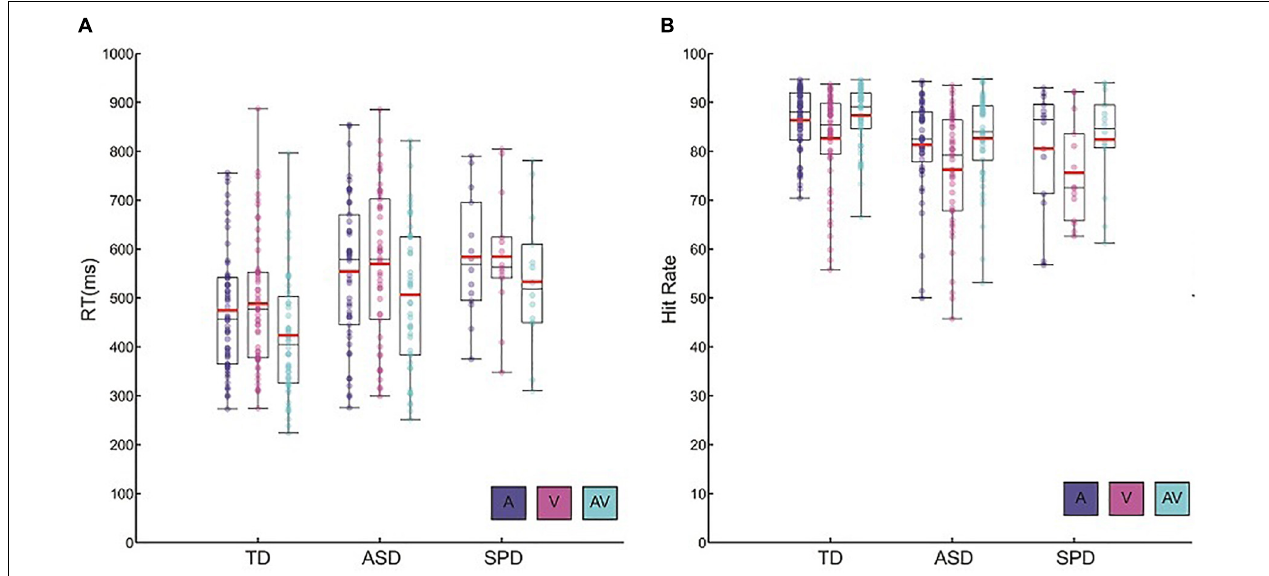
FIGURE 1 | Behavioral data. (A) Reaction time data for each of the diagnostic groups and the three stimulus conditions. Circles represent each participant’s mean RT for a given condition. Red horizontal bars indicate the mean across participants within a given group and condition. Black rectangles represents 25th and 75th group percentile bounds, and the horizontal black line within each rectangle is the group median. Whiskers extend to the minimum and maximum data points. (B) Hit rate data for each diagnostic group and condition. Plotting conventions are the same as those used for the RT